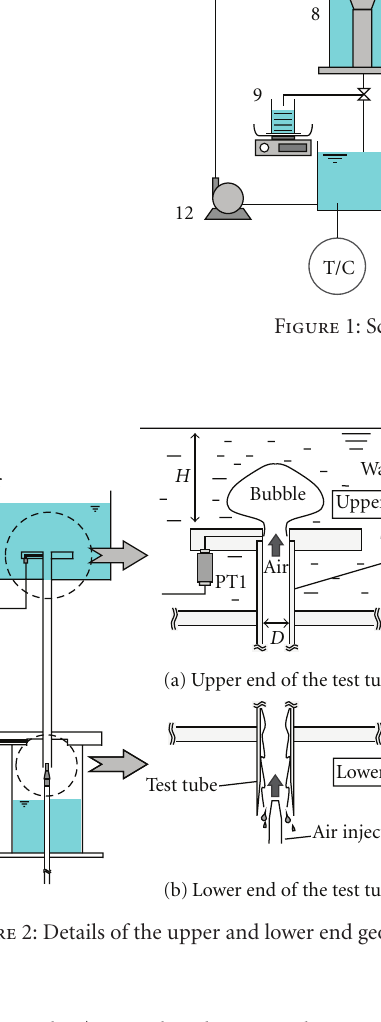
where j ∗ and j ∗ are the dimensionless gas and liquid g l superficial velocities given by